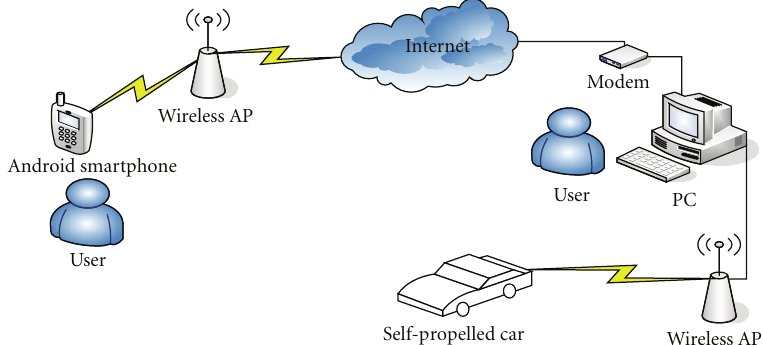
Figure 5: Smartphone control system.